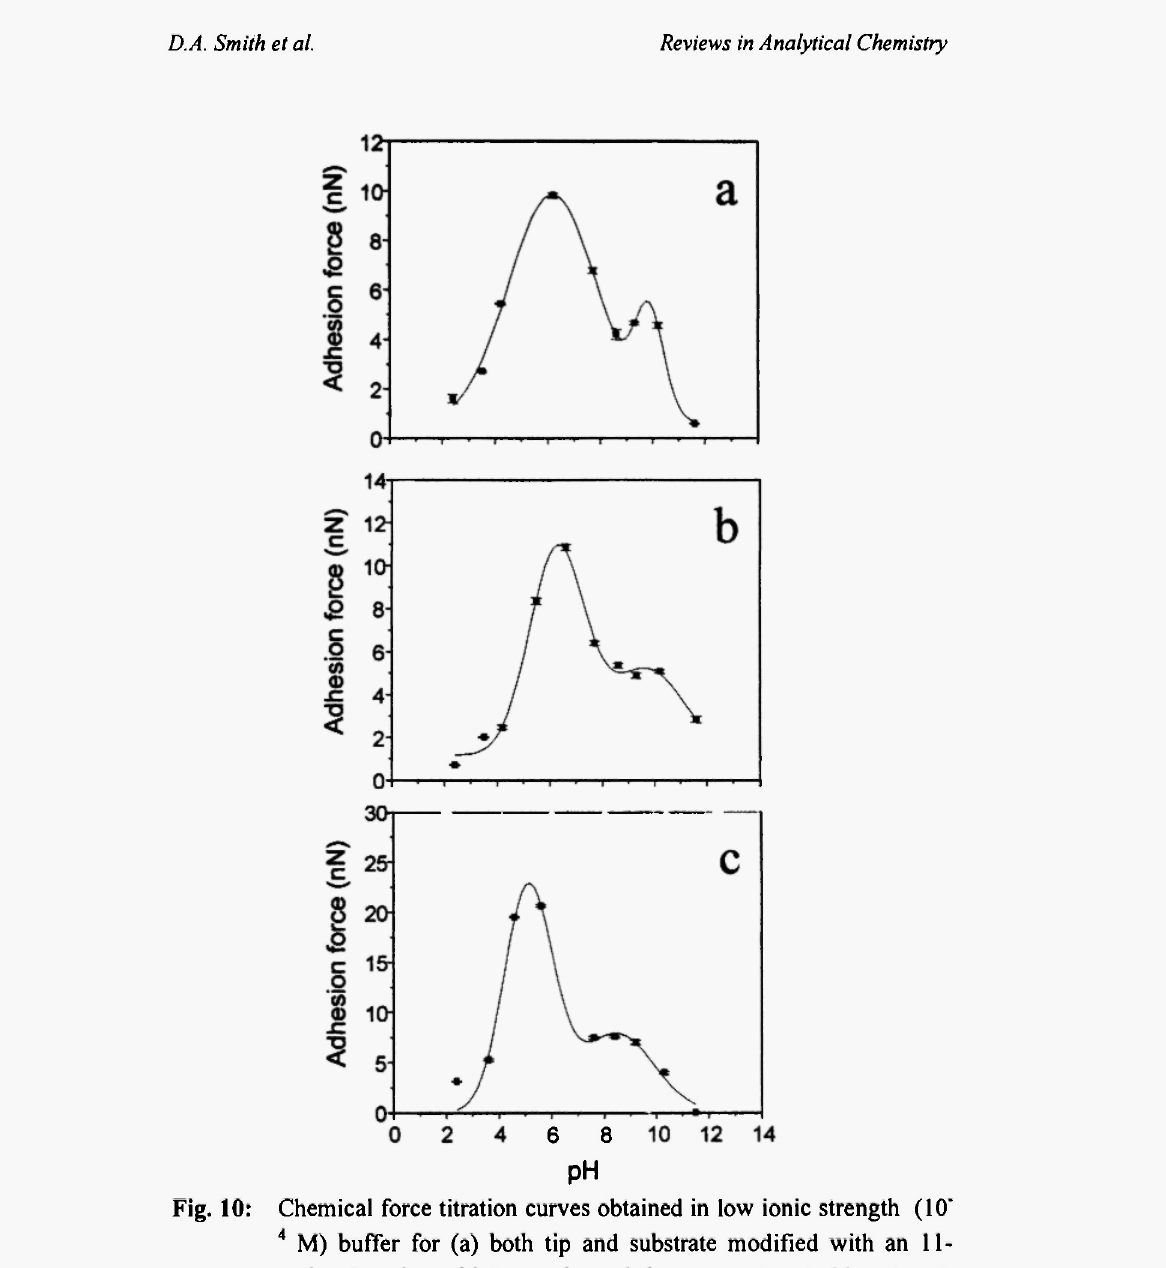
Fig. 10: Chemical force titration curves obtained in low ionic strength (10' 4 M) buffer for (a) both tip and substrate modified with an 11- amino-l-undecanthiol monolayer (alkyl spacer length 11 carbons), (b) tip modified with an 11-amino-1-undecanethiol monolayer and substrate with a 2-aminoethanethiol (alkyl spacer length 2 carbons on substrate) and (c) both tip and substrate modified with a 2- aminoethanethiol monolayer. (The curves have been added as a guide to the